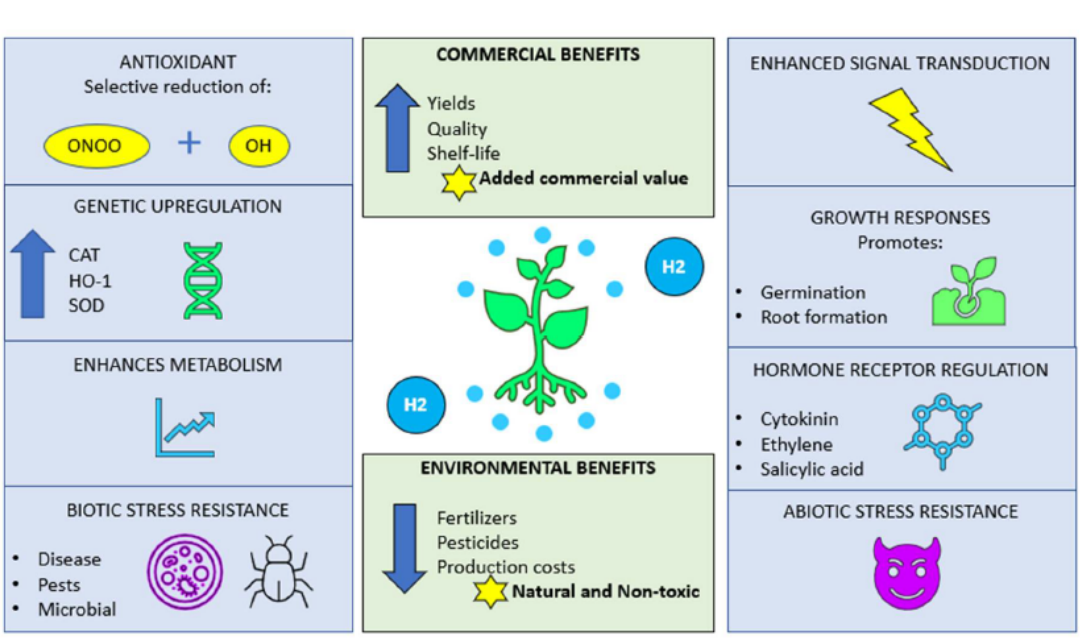
Figure 2. Possible mechanisms by which H 2 acts in as a protective agent within plant systems. Several ways are shown by which H 2 may act, whilst highlighting the benefits for both agricultural and environmental sustainability. ONOO: peroxynitrite; OH: hydroxyl radical; CAT: catalase; HO-1; haem oxygenase-1; and SOD: superoxide dismutase.